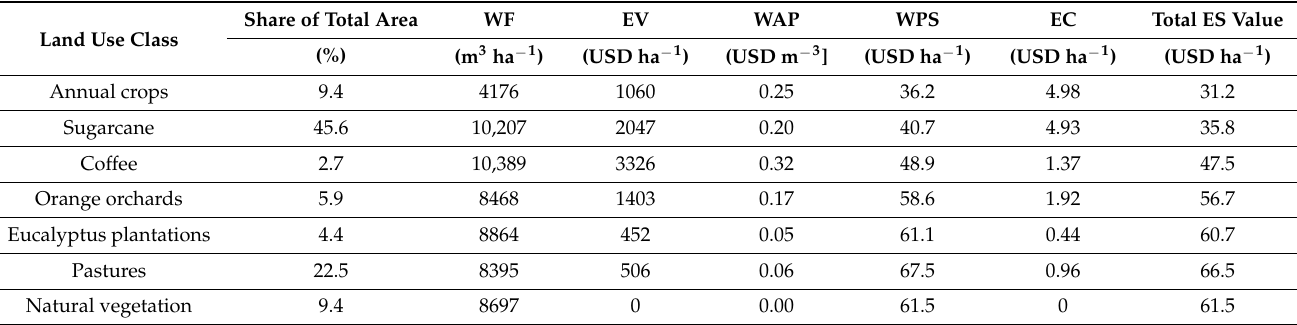
Table 2. The percentage share of the total land area per land use and average values of water